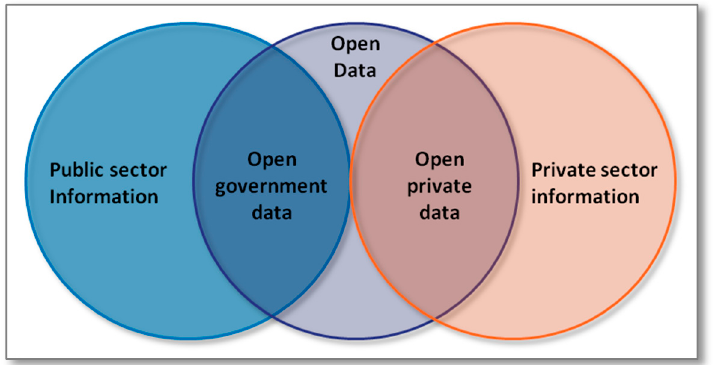
Figure 3. Open data in the big data economy. Reproduced from reference [11], with permission from European Data Portal, 2017.